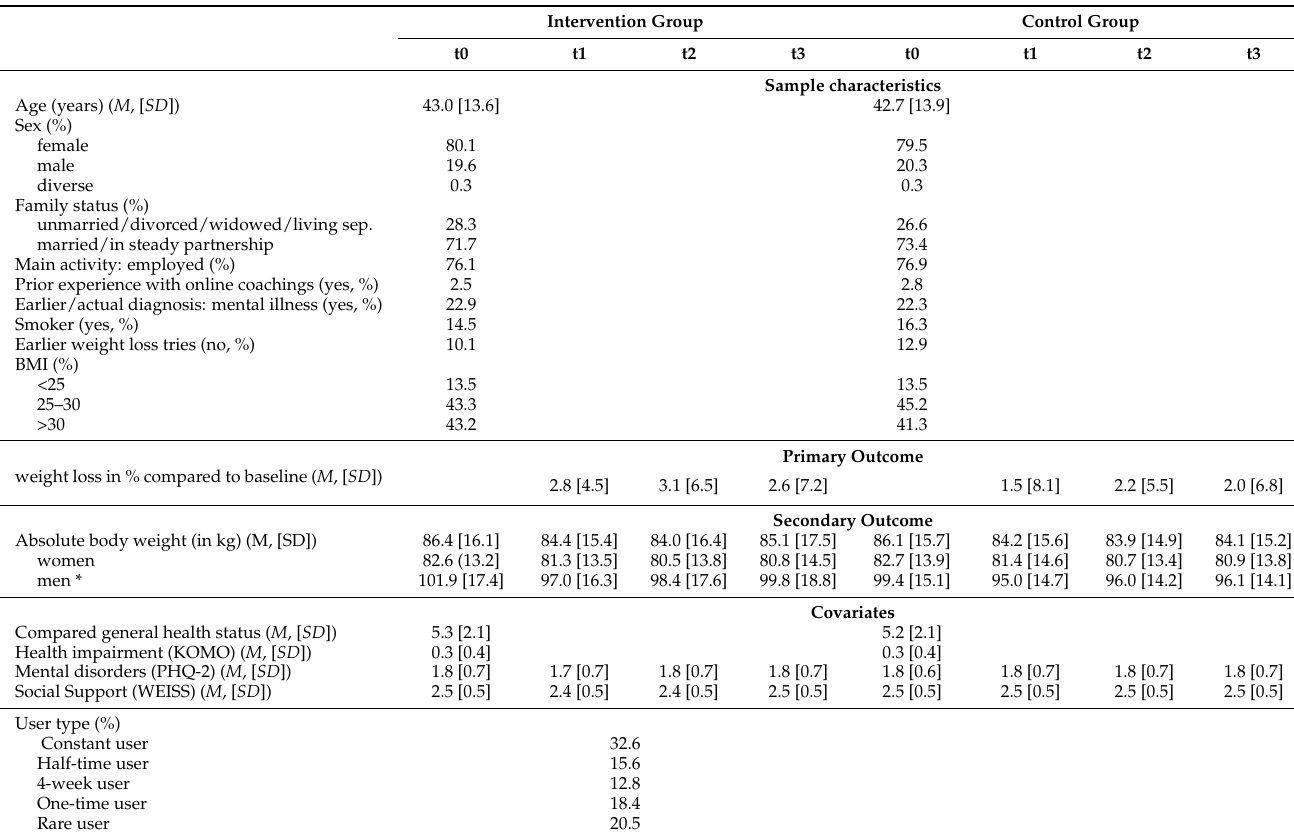
Table 1. Sample characteristics (intention-to-treat